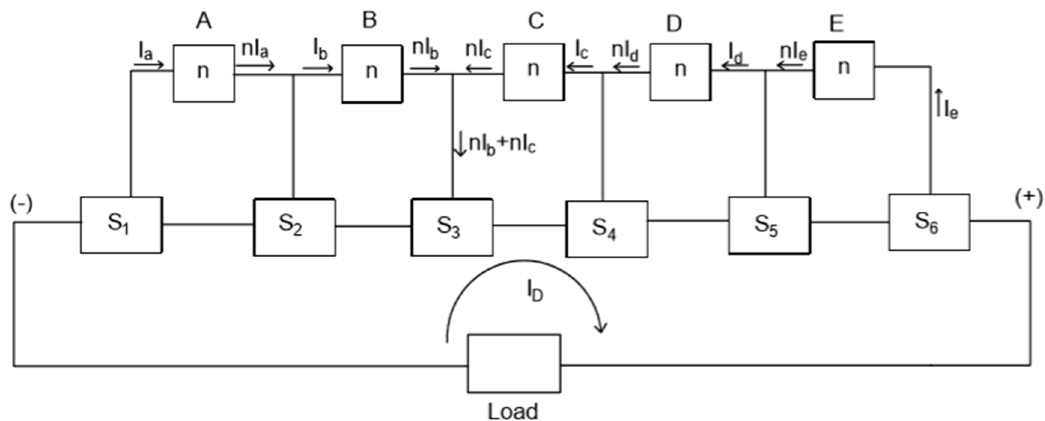
Figure 8. AEQ flow diagram for Tests 1 and 2.